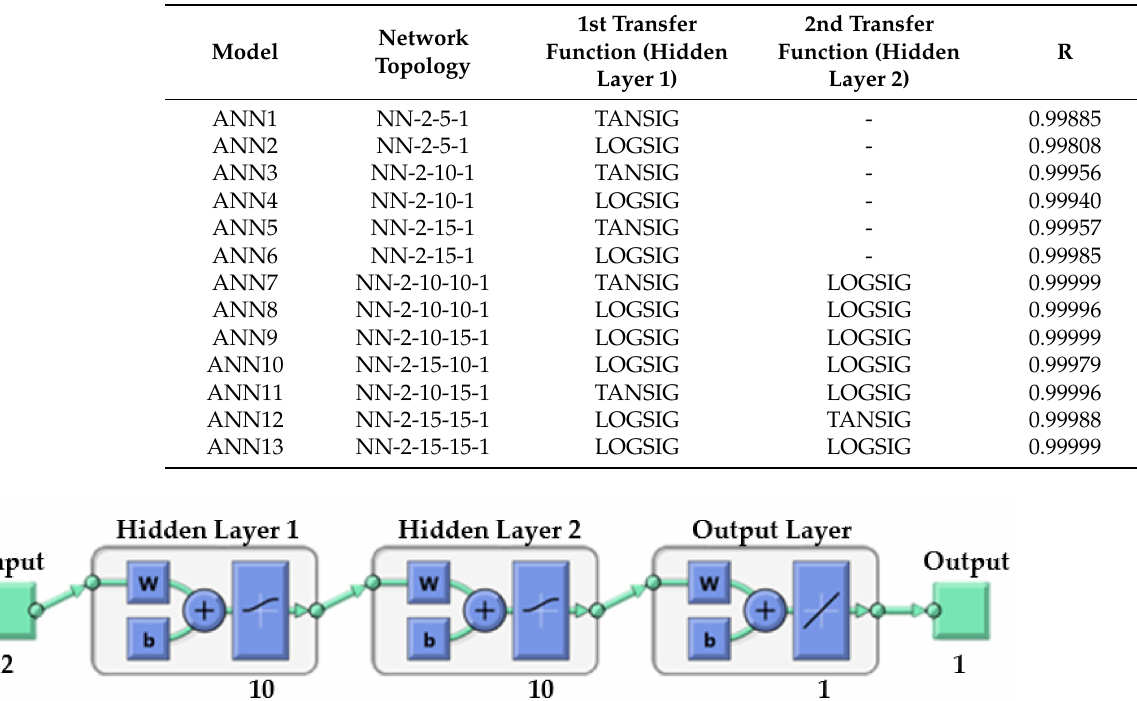
Table 10. Prediction performance of different ANN structures.